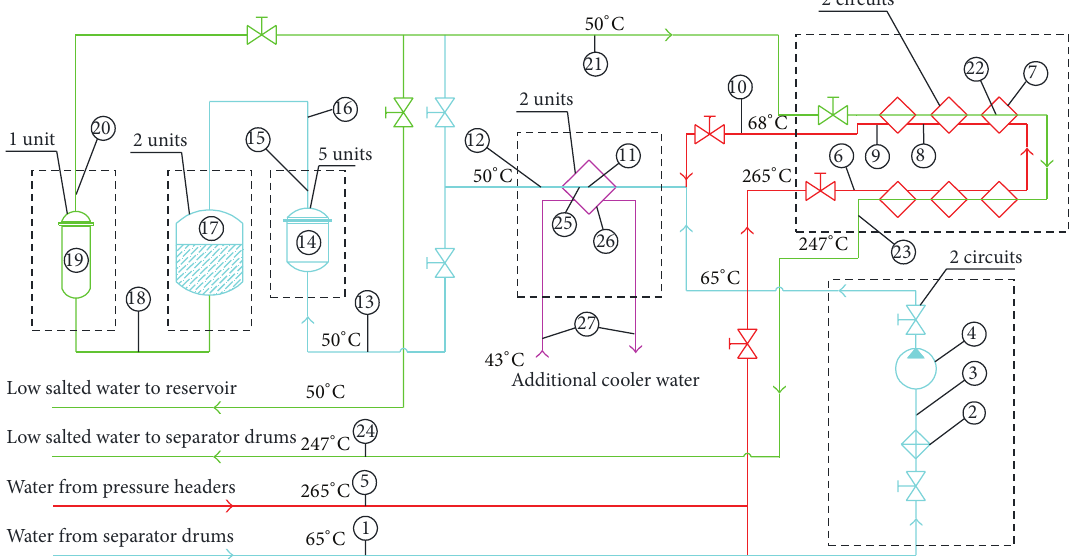
Figure1:SimplifiedPCSscheme:1–17:subsystemofnonpurifiedwater,18–24:subsystemofpurifiedwater,and25–27:subsystemofadditional cooling